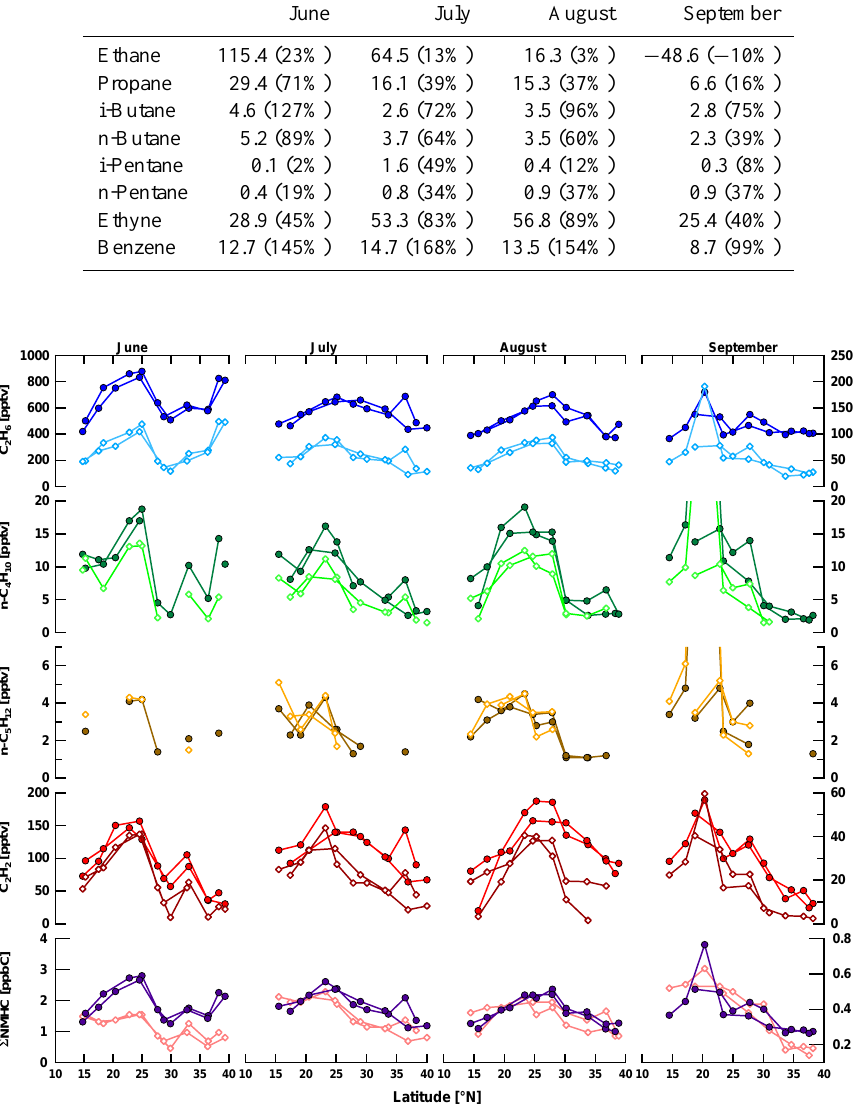
Fig. 4. Latitudinal profiles of NMHCs measured during June-August flights between FRA and MAA. Filled circles represent the compounds on the left axis, open diamonds to the compounds on the right axis. For the sample in September collected at ∼ 19 ◦ N for which n-butane, i-butane, n-pentane and i-pentane are off-scale, the corresponding mixing ratios are 62pptv, 44pptv, 25pptv and 32pptv,